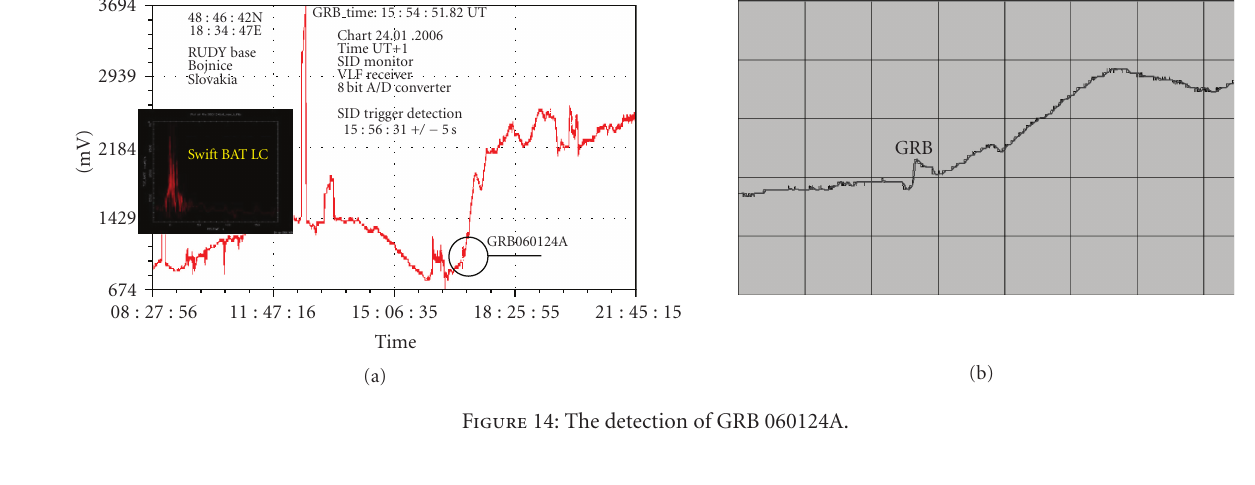
Figure 14: The detection of GRB 060124A.